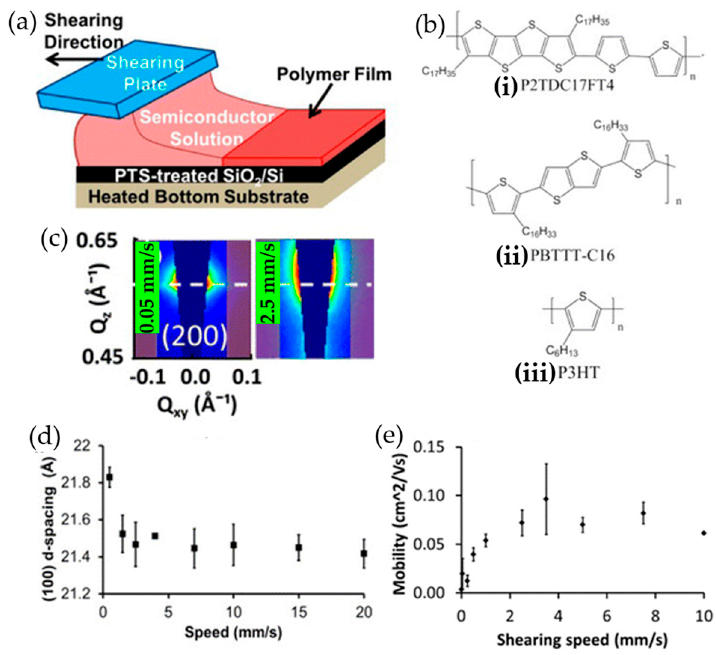
Figure 8. ( a ) Schematic illustration of solution shearing. ( b ) Chemical structures of polymers used in solution shearing: (i) P2TDC17FT4; (ii) PBTTT-C16; (iii) P3HTT. ( c ) The (200) Bragg peak position of a P2TDC17FT4 thin film solution sheared at 0.05 and 2.5 mm/s. The white dashed line indicates the (200) Bragg peak position of a dropcast sample. ( d ) Lamellar spacing of P2TDC17FT4 thin films as a function of shearing speed. ( e ) Average mobilities of the solution sheared P2TDC17FT4 TFTs as a function of shearing speeds. The error bars show the standard deviation. Reproduced with permission from [53]. Copyright 2015 American Chemical Society.